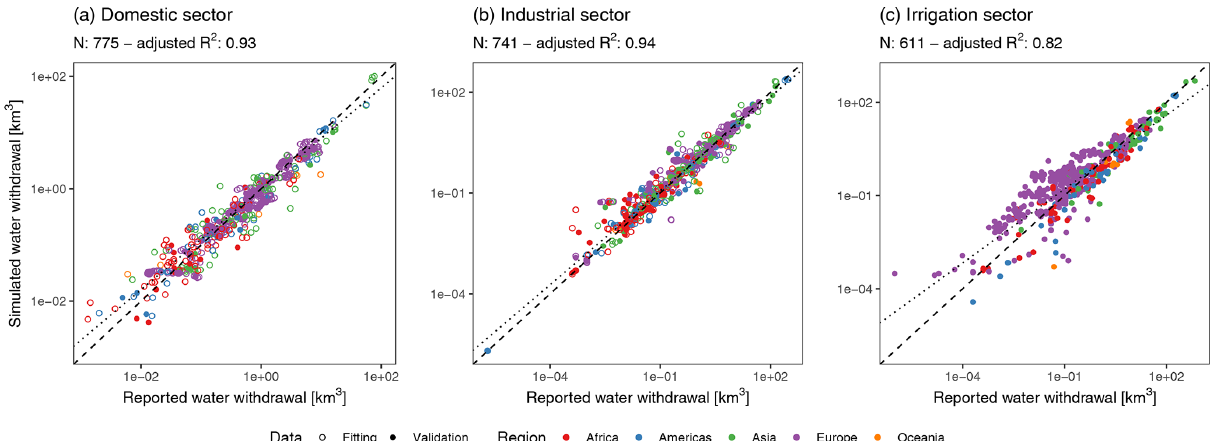
Figure 2. Comparison between simulated national annual water withdrawals and the FAO-reported values for the (a) domestic, (b) industrial, and (c) irrigation sectors. Colours distinguish between regions. Open circles were also used in the calibration of the water withdrawal demands. The dashed line indicates the 1 : 1 ratio, and the dotted line indicates the simulated best linear fit. Note the log–log axis which is used to display the wide range of water withdrawals. The adjusted R 2 is also based on the log values.